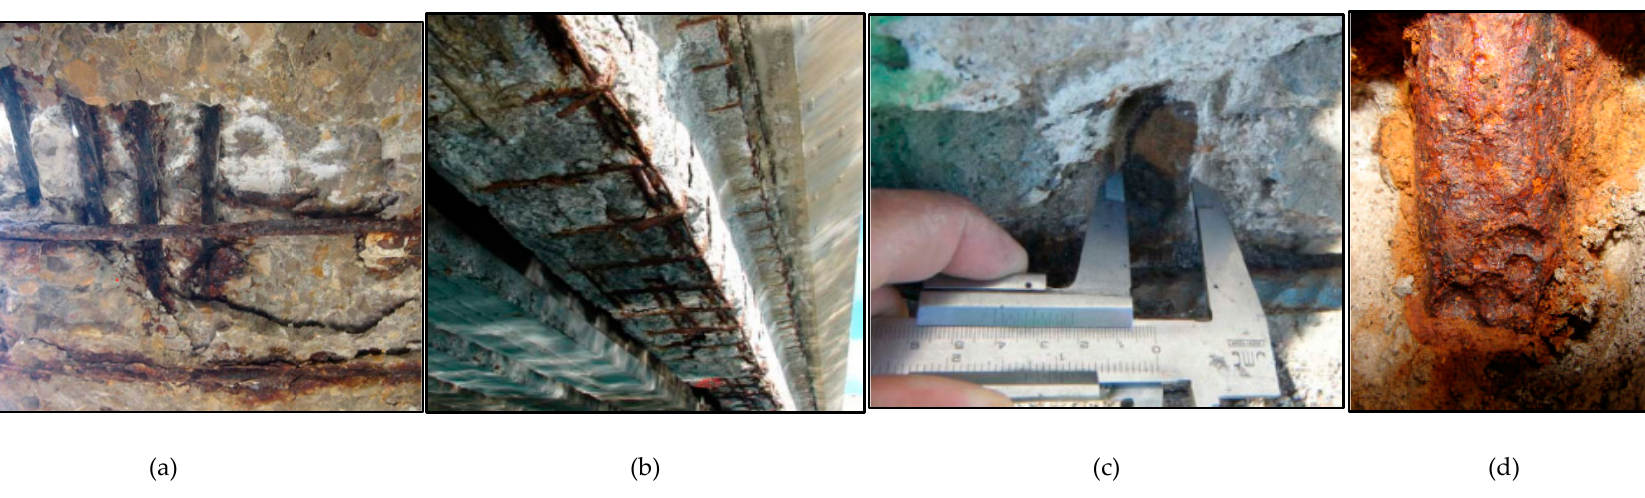
Figure 4. Structures with severe reinforcement corrosion problems. Photos obtained from the available documentation of some of the case studies (Source: Technical Institute of Materials and Constructions (INTEMAC); different dates). ( a ) Viaduct 4–Beam 7, ( b ) Pier 2–Beam 1, ( c ) Viaduct 3–Pile 20, and ( d ) Viaduct 2.